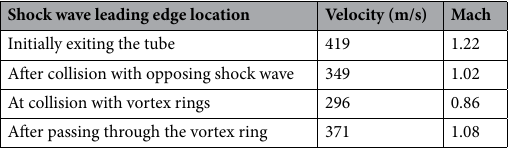
Table 1. Shock wave velocity throughout the collision process.